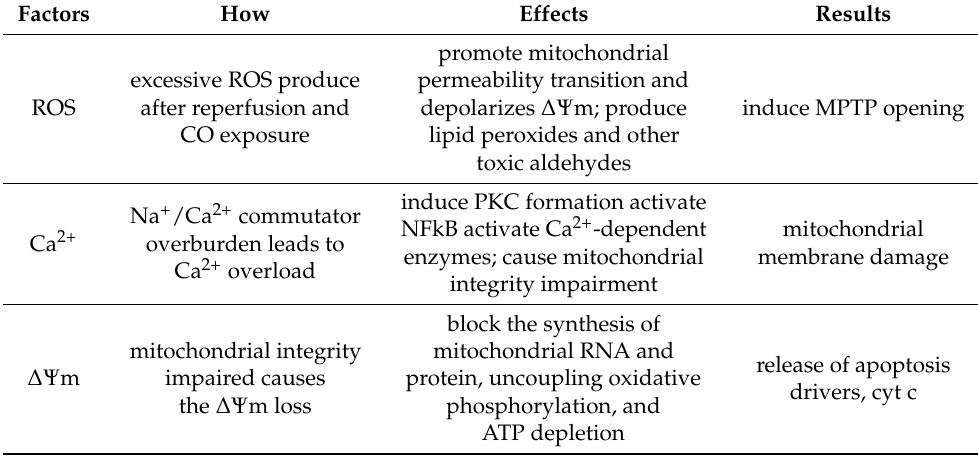
Table 1. Influencing factors of MPTP opening. Excessive ROS, elevated calcium, and decreased ∆Ψ m; these factors are interconnected and can lead to the same events: the MPT pore opening, damage to mitochondrial membranes, and release of pro-apoptotic